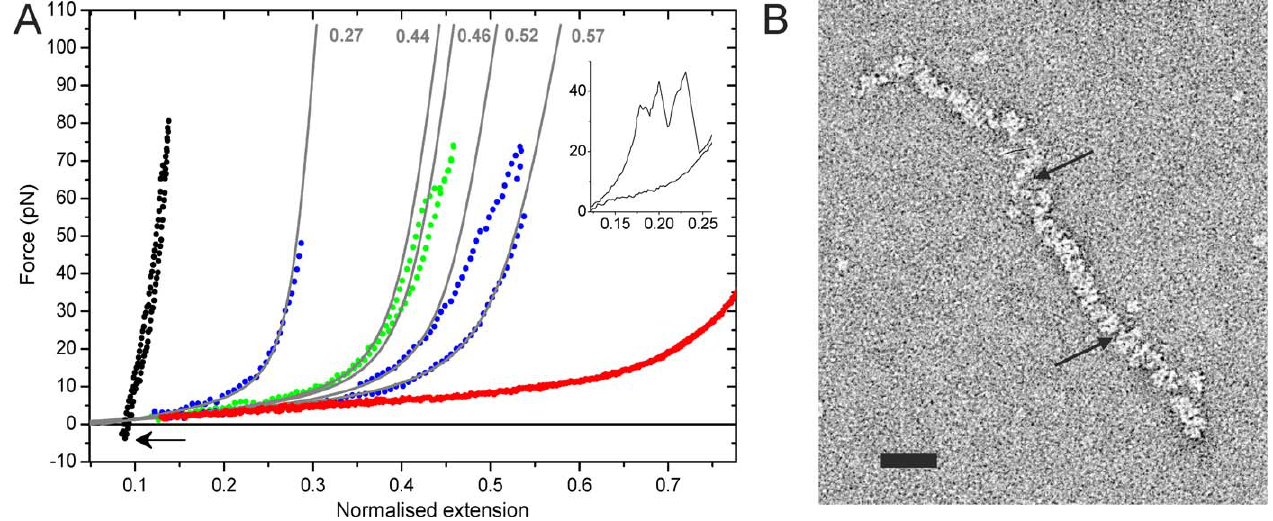
Figure 3. Fully Covered ssDNA-VirE2 Filaments Consist of Stiff Rods (A) Force versus extension curves of fully coated (black), partially coated (blue, green) ssDNA-VirE2 filaments, and uncoated ssDNA (red) in assembly buffer at low protein concentration. Extension curves are normalized to the contour length of ssDNA measured prior to exposure to VirE2. Three typical ssDNA-VirE2 curves were recorded within ; 120 s. Gray lines are extensible FJC fits; the numbers (top) indicate the fraction of uncoated ssDNA. Abrupt jumps in the force-extension curve indicate cooperative release of VirE2 domains (blue curve and sawtooth pattern in inset). Multiple pull-and-release cycles produce a single rigid helical domain (black curve) that resists compression forces of ; 3.5 pN (obtained by reversing the direction of pulling [buckling force, arrow]). (B) ssDNA–VirE2 complexes observed by negative-stain EM showing multiple nucleation sites leading to different VirE2-ssDNA helical domains, which are not in register (arrows indicate the separation between helical domains). Scale bar: 30 nm.